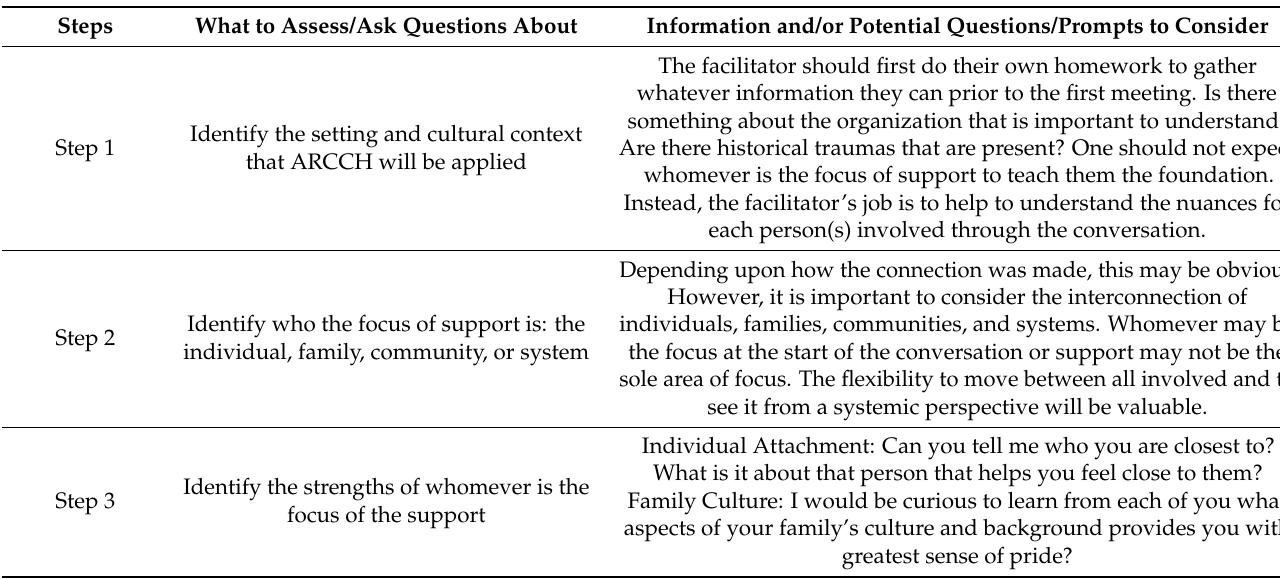
Table 1. 5 Step Guide to Using the ARCCH Model of